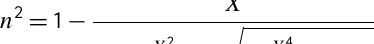
Fig. 6. Cutoff elevation angles as a function of the ratio X ( = ω 2 p /ω 2 ) at the location of the peak electron density for the O-mode (lower curve) and X-mode (upper curve). Waves launched from the Saskatoon SuperDARN at lower elevation angles than these will be refracted back to Earth and not detected by the RRI on